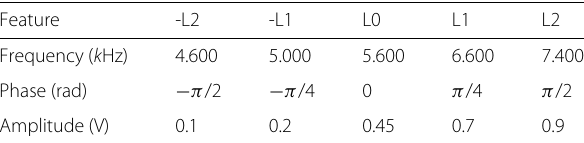
Table 3 Base signal